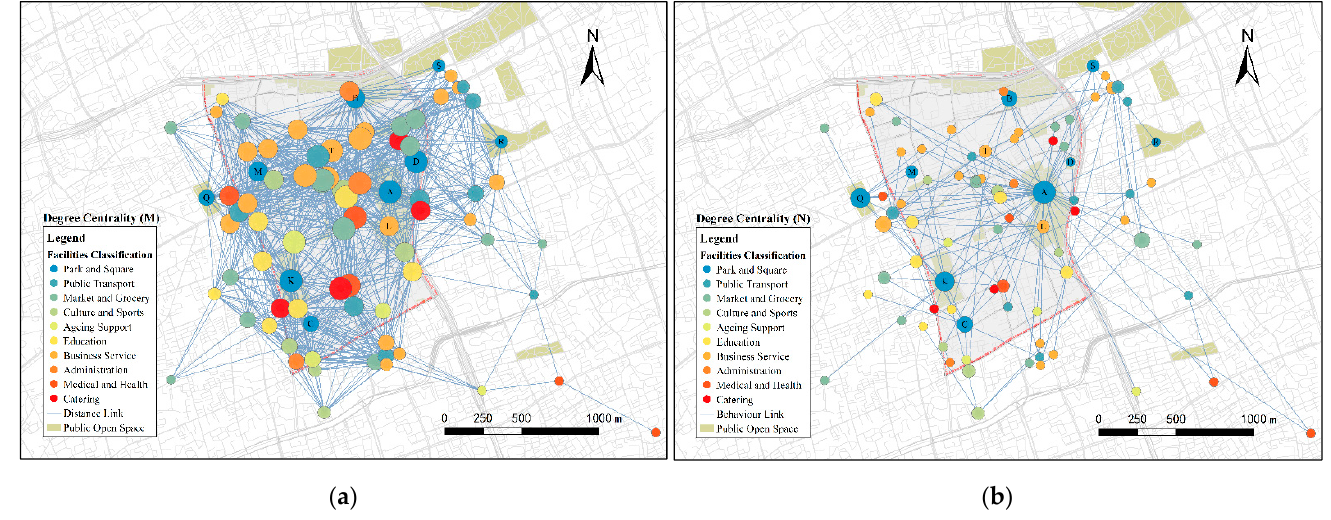
( b ) Figure 5. LS between nodes: ( a ) LS in the spatial network; ( b ) LS in the behaviour network. 4.3. Node Characteristics 4.3.1. Degree Centrality There was a small difference in the DC of each node in the spatial network M, with nodes closer to the community centre presenting a higher score; the scores of the POSs in the network were generally moderate or low (Figure 6a). In the behaviour network N, the